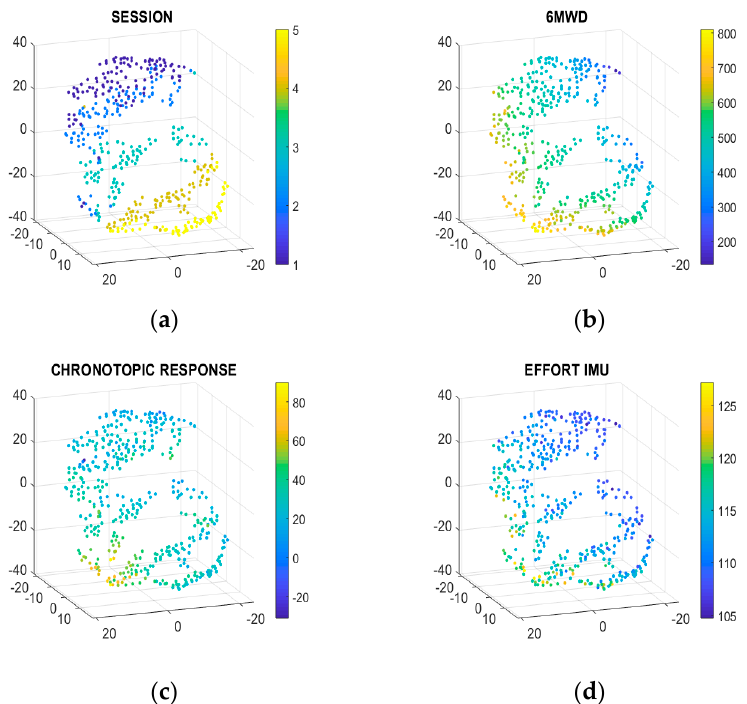
Figure 4. ( a ) t-distributed stochastic neighboring embedding (t-SNE) projection, colors represent rehabilitation time (session number) (upper left graph); ( b ) t-SNE projection, colors represent distance. Note that distance has not been used as input feature in the model, but it has only been used to color the map (upper right graph); ( c ) t-SNE projection, colors represent chronotropic response (bottom left graph); ( d ) t-SNE projection, colors represent effort during the last 2 min of the 6MWT (bottom right graph). The axes do not represent distance or time but are the results of a composite projection of features in a 3D space.